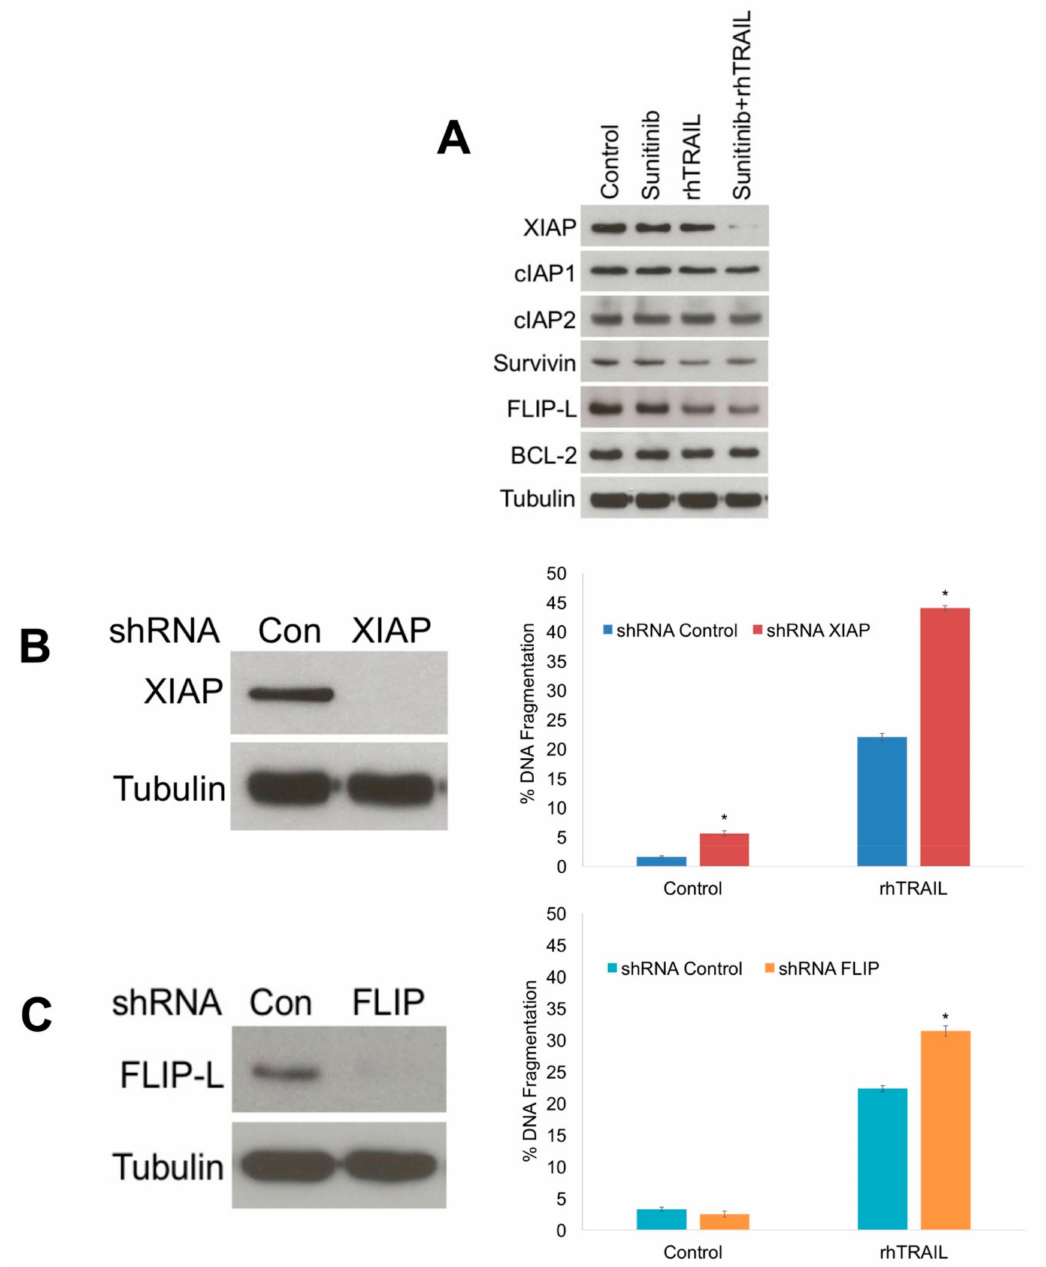
Figure 3. X-linked inhibitor of apoptosis protein (XIAP) downregulation sensitizes HCT116 cells to recombinant human tumor necrosis factor-related apoptosis-inducing ligand (rhTRAIL)-mediated apoptosis. ( A ) HCT116 cells were treated with rhTRAIL, sunitinib, and the combination for 24 h. IAPs, FLIP-L, and BCL-2 levels were measured by immunoblotting. ( B , C ) Knockdown of XIAP and FLIP sensitizes HCT116 cells to rhTRAIL-mediated apoptosis. XIAP and FLIP expression were silenced by shRNA. Cells were treated with 100 ng / mL rhTRAIL for 24 h and apoptosis was measured by propidium iodide fluorescence activated cell sorting (PI-FACS) analysis. Mean ± Standard Deviation (SD), n = 3. * Indicates a significant di ff erence compared to shRNA Control cells, p <